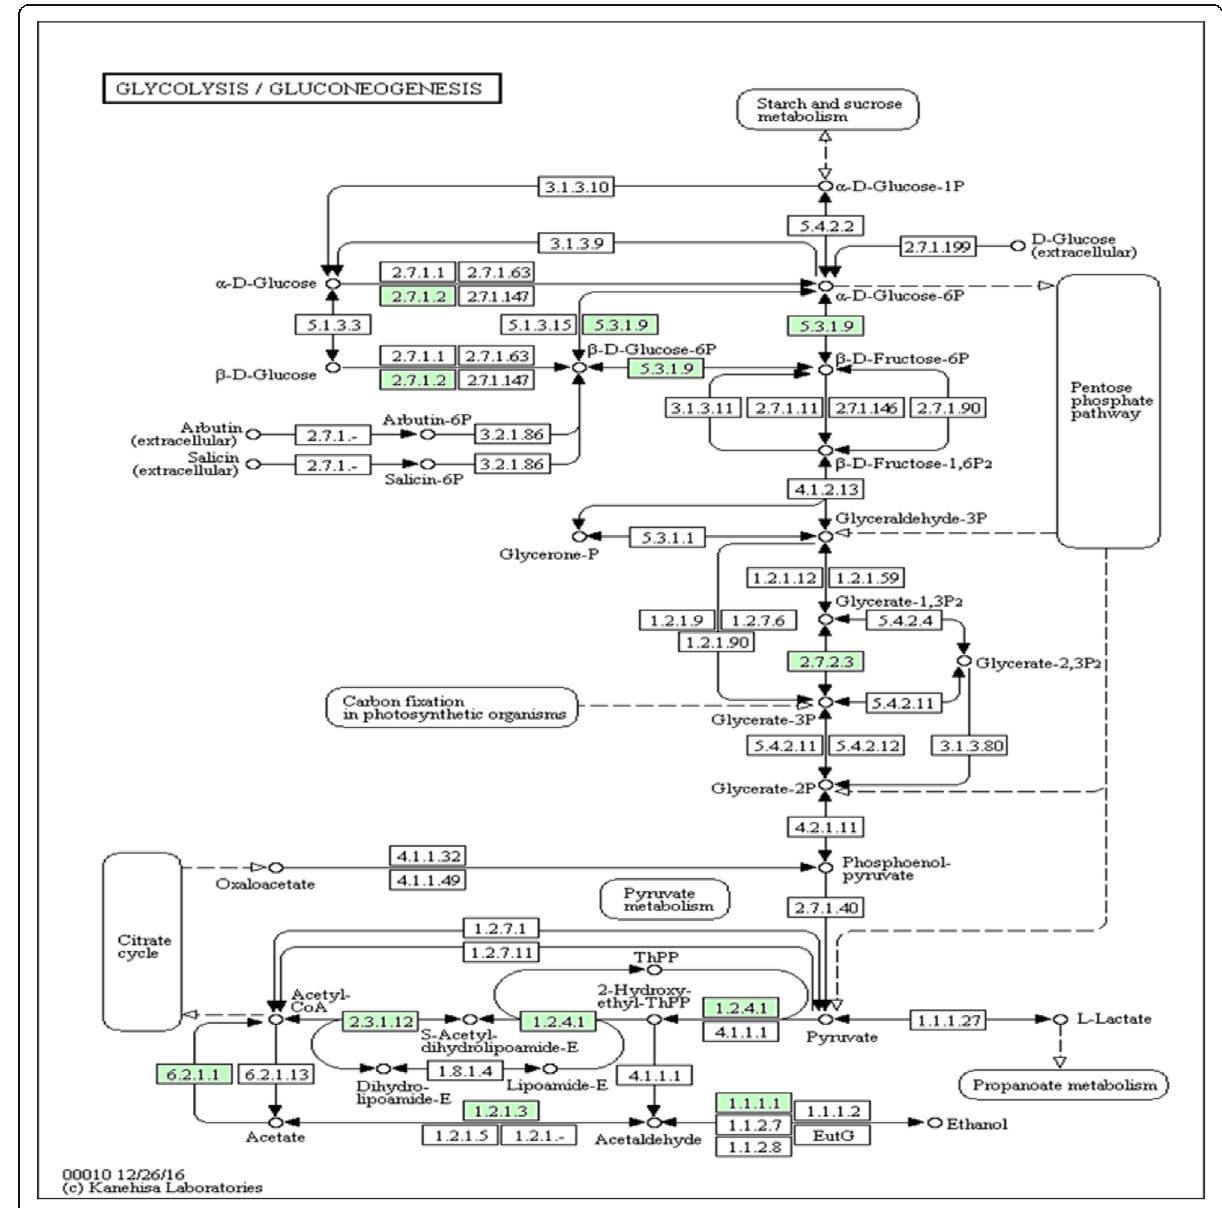
Fig. 1 Pathway of glycolysis/gluconeogenesis performed using the KEGG pathway in KEGG Orthology. EC numbers in green are the enzymes identified in AB1